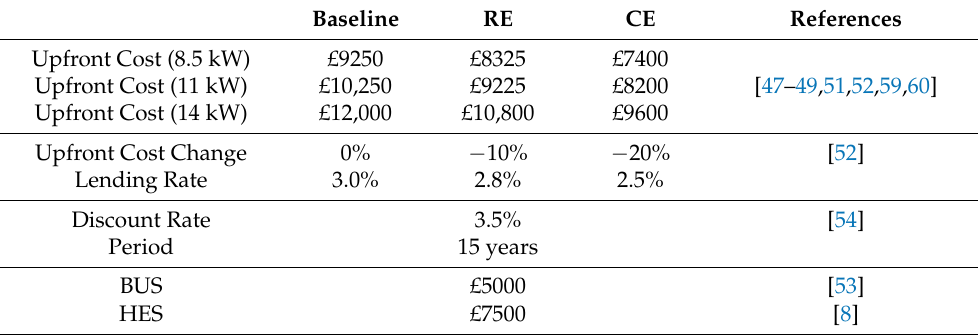
Table 1. Summary of assumptions for life cycle cost analysis and future